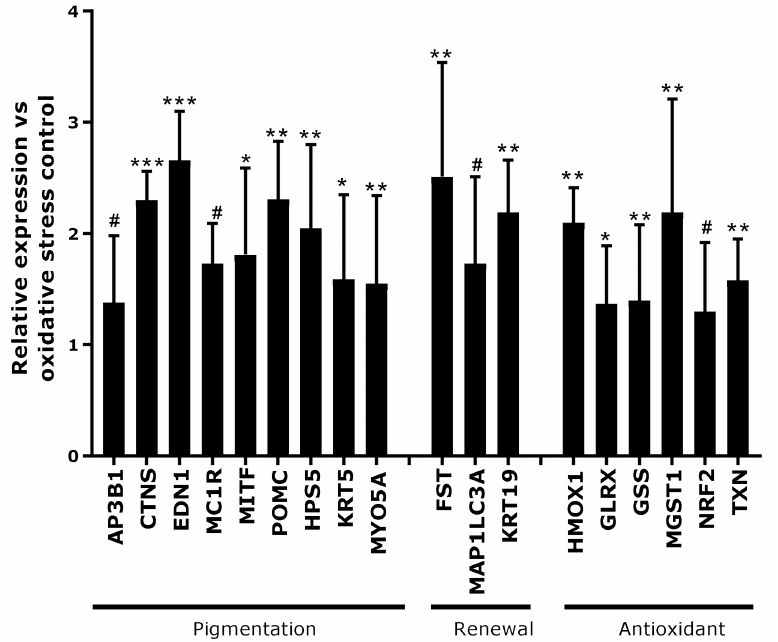
Figure 4. Gene expression analysis in scalp skin explants in a canities-induced condition following treatment with the active ingredient at 1%. The results (mean ± SEM) are expressed as relative expression versus the oxidative stress control condition. Statistical analysis was performed using one-way ANOVA followed by Fisher’s t -test in comparison with oxidative stress control condition, with # p < 0.1, * p < 0.05, ** p < 0.01 and *** p <